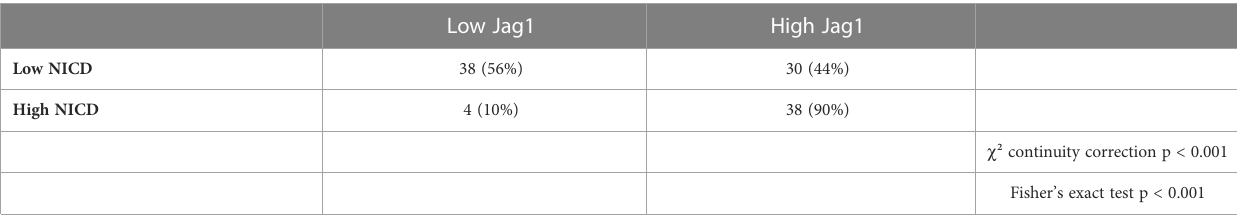
Jag1, Jagged-1; NICD, Notch intracellular